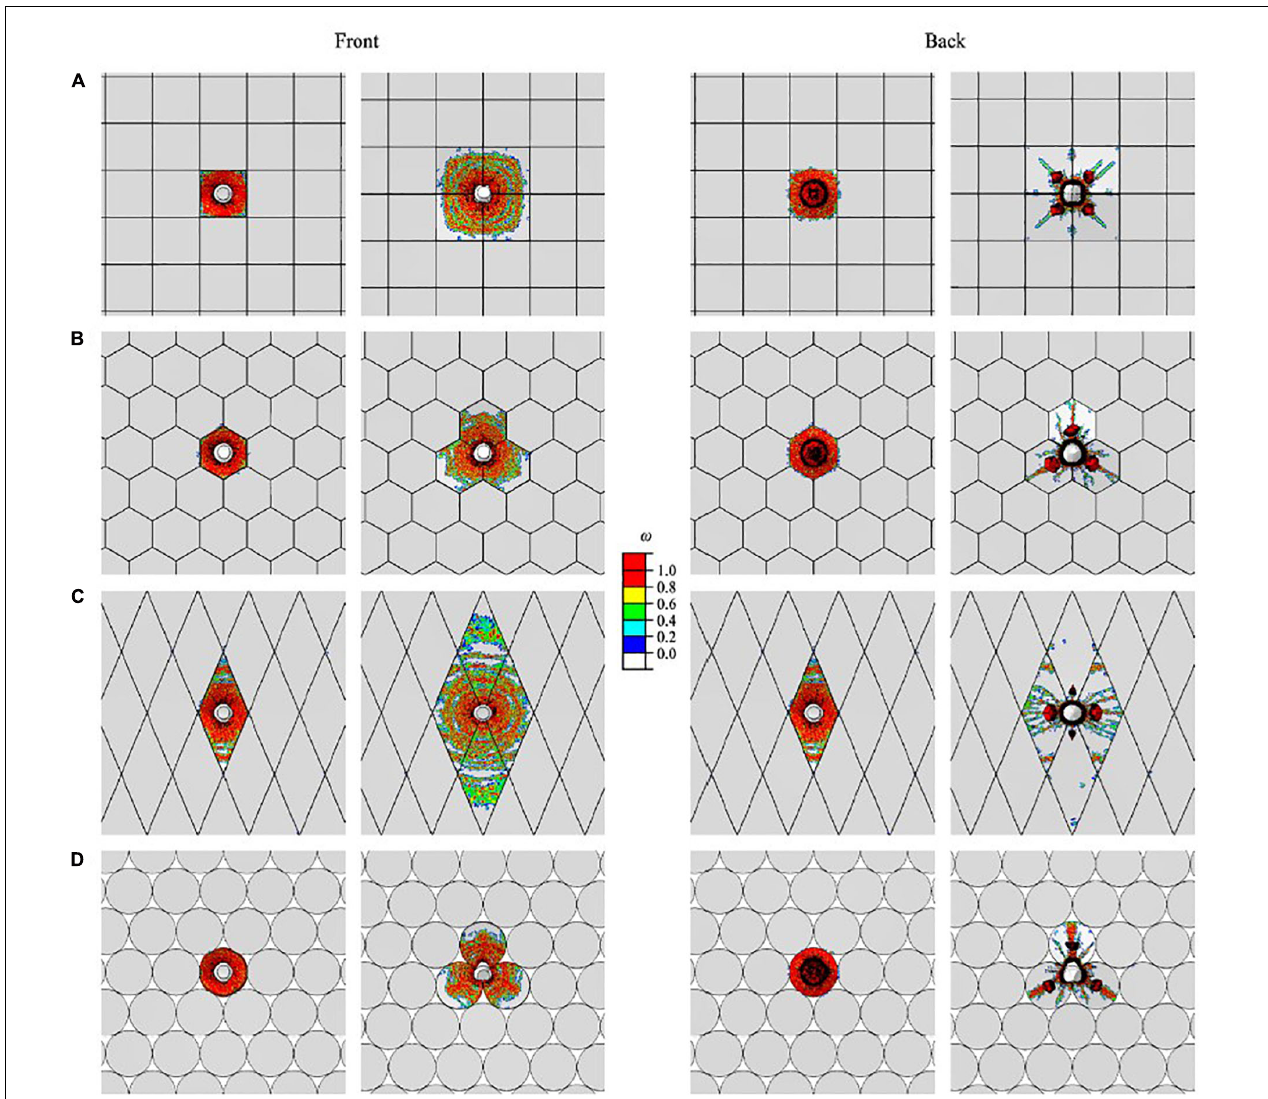
FIGURE 7 | Impact of projectile on segmented composite armor (A) square, (B) hexagonal, (C) rhombic, and (D) circular geometries to observe force distribution when the impact is on center of scale (on left column) and when off-center (on the right column) (Miranda et al.,